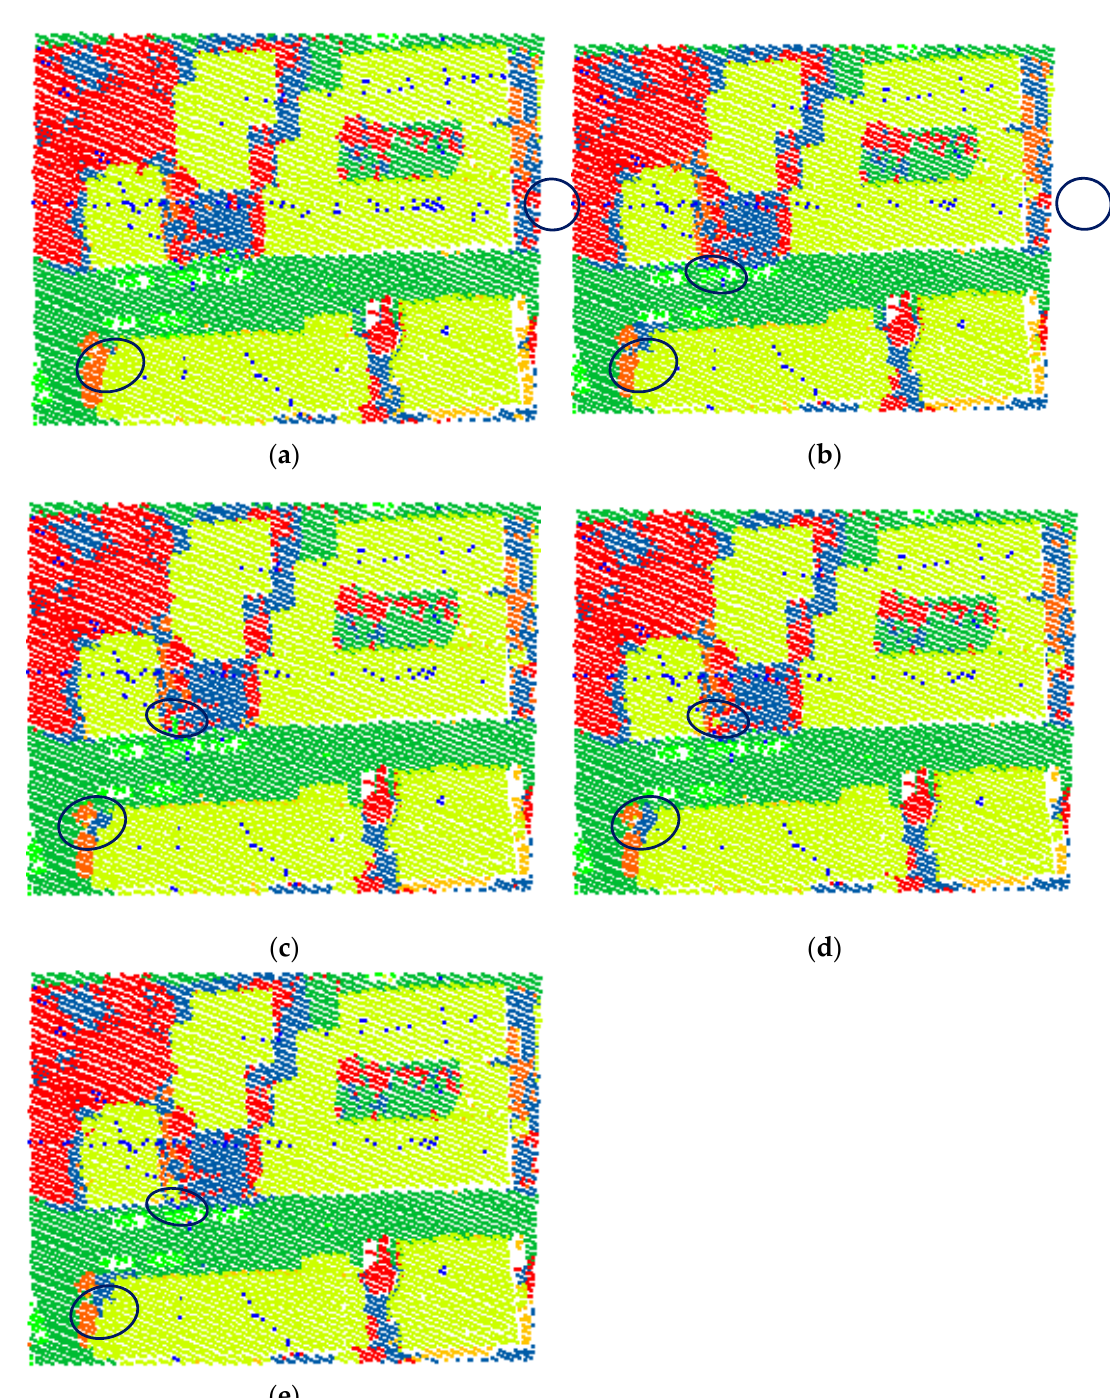
Figure 8. Classification results with different model configurations. ( a ) Baseline model, ( b ) baseline model with the proposed normal vector, ( c ) our model with both normal vector and atrous convolution, ( d ) our model with the normal vector, atrous convolution, and reweighted loss function, and ( e ) ground truth. The black circled parts highlight the differences among ( a – e ). ( a ) Baseline, ( b ) Ours (normal vector), ( c ) Ours (normal vector and atrous convolution), ( d ) Ours (final), ( e ) Ground truth. Table 4. Ablation study results.